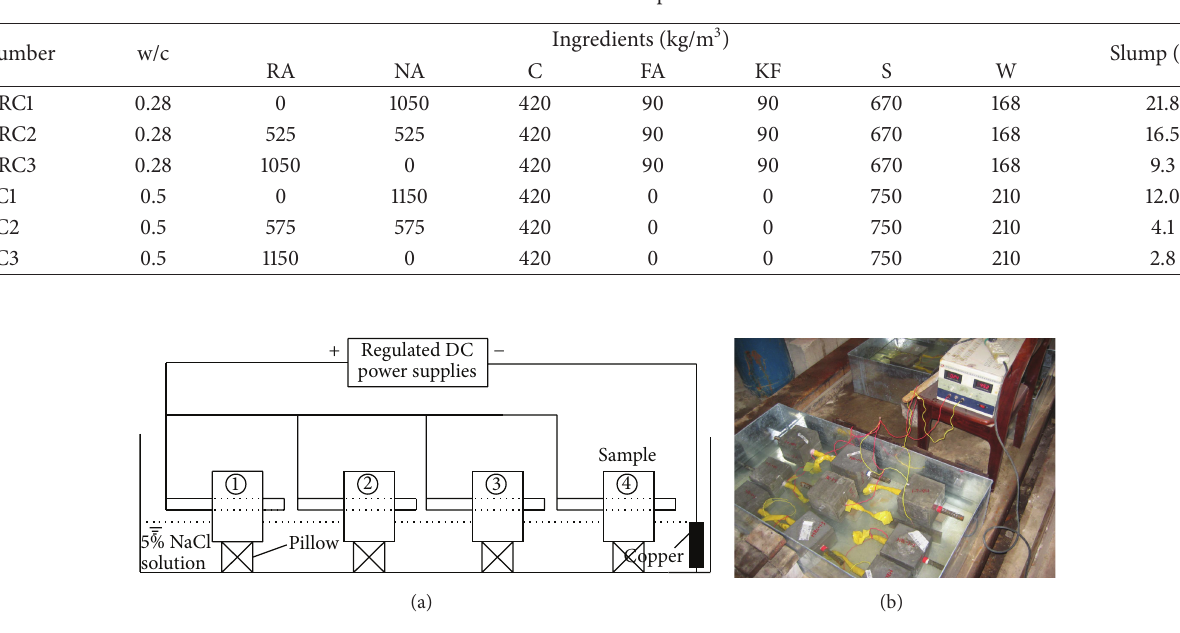
Table 2: Mixtures of specimen.